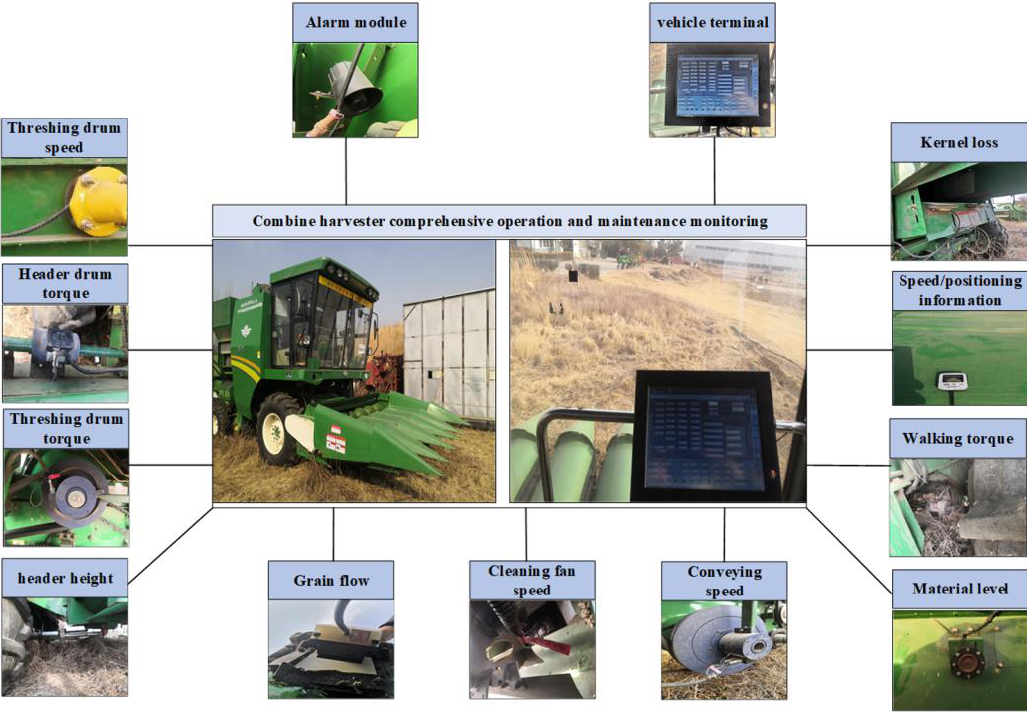
Figure 1. Structure of fault diagnosis and monitoring system of combine harvester.